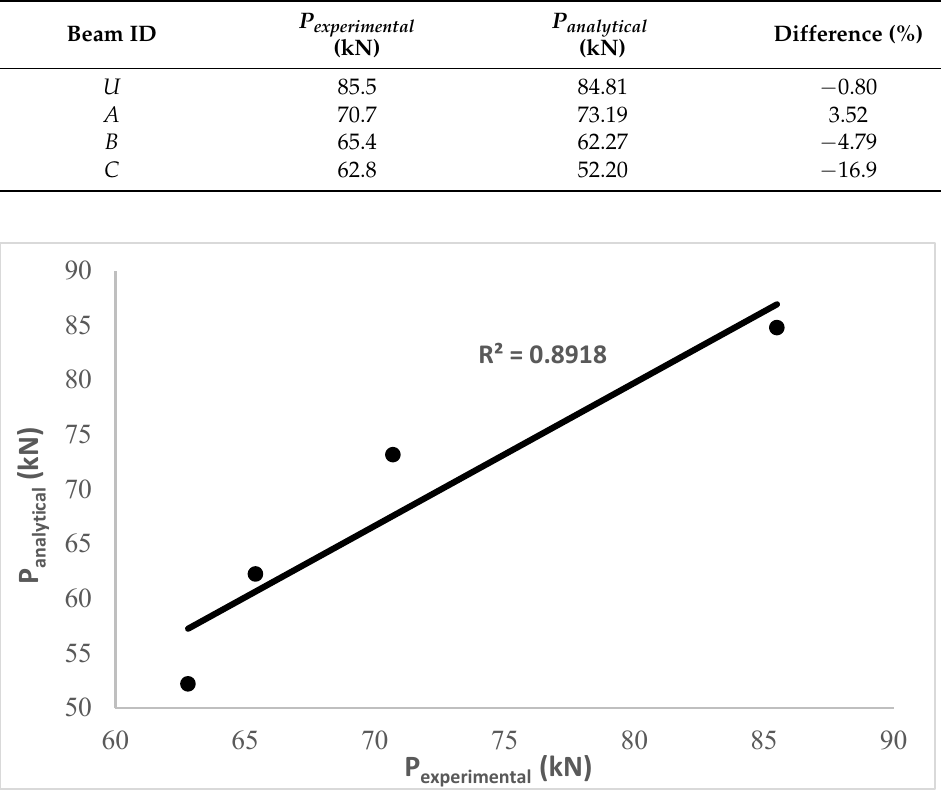
Figure 18. Comparison between experimental and analytical results using targeted mass loss.